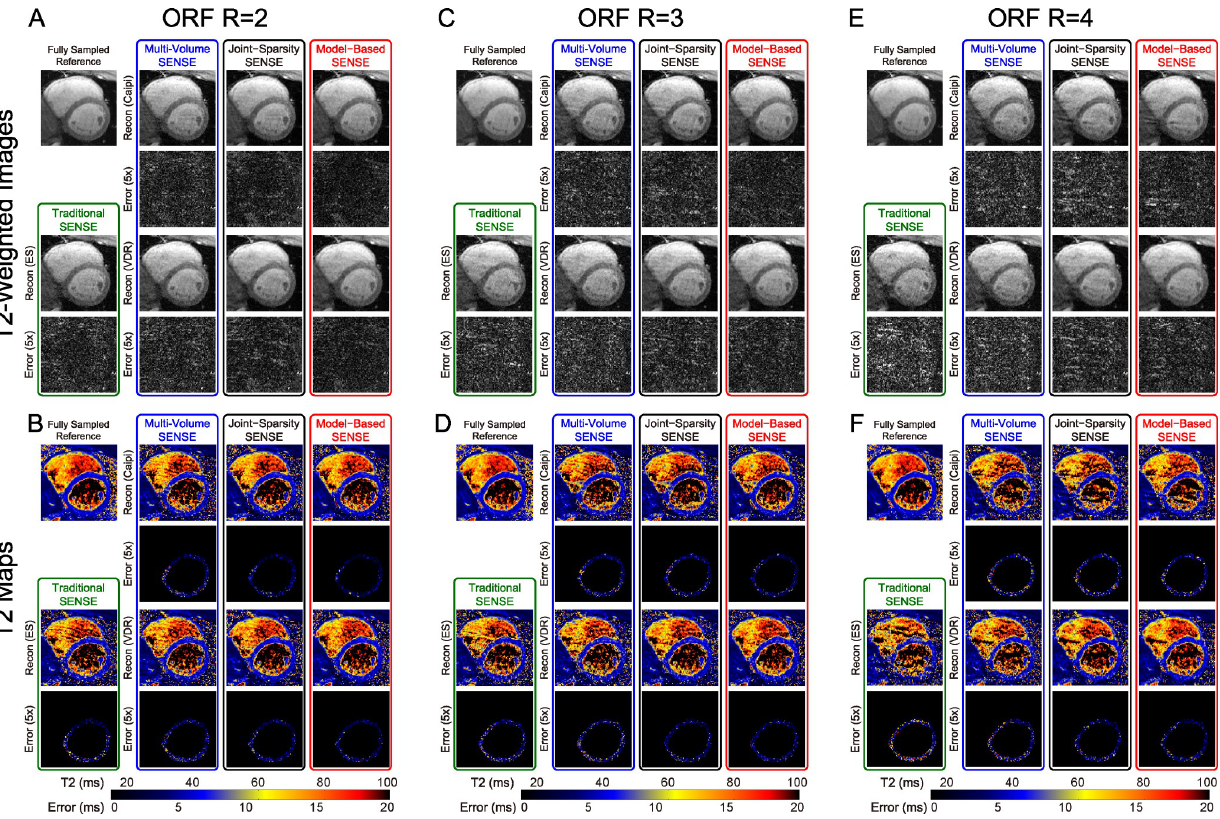
Fig 5. T2-weighted images and T2 maps from a normal human subject with ORF = 2–4 and all reconstruction approaches. Data is displayed in the same manner as in Fig 3. As ORF increases (left to right), artifacts become apparent for all methods, most severely for Traditional SENSE and least for VDR sampling. Consistent with the observations in swine (Fig 3), at ORF = 4, images based on Caipi sampling pattern suffer from significant ghosting artifacts, which are reduced with VDR sampling.